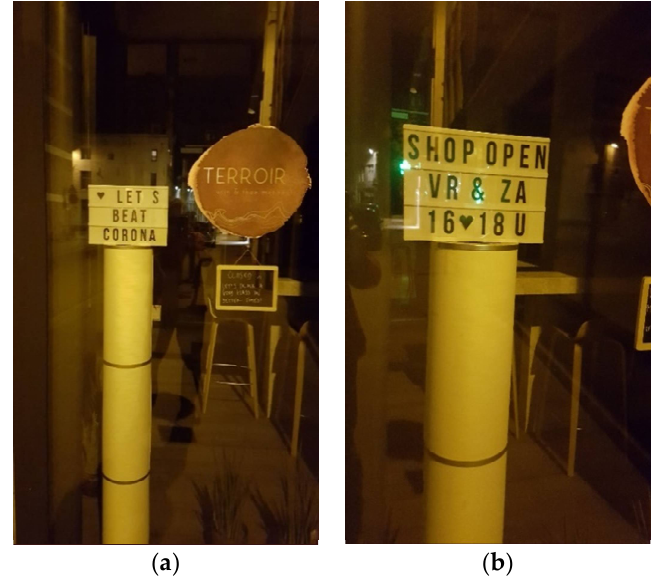
Figure 1. ( a , b ): Let’s beat corona.